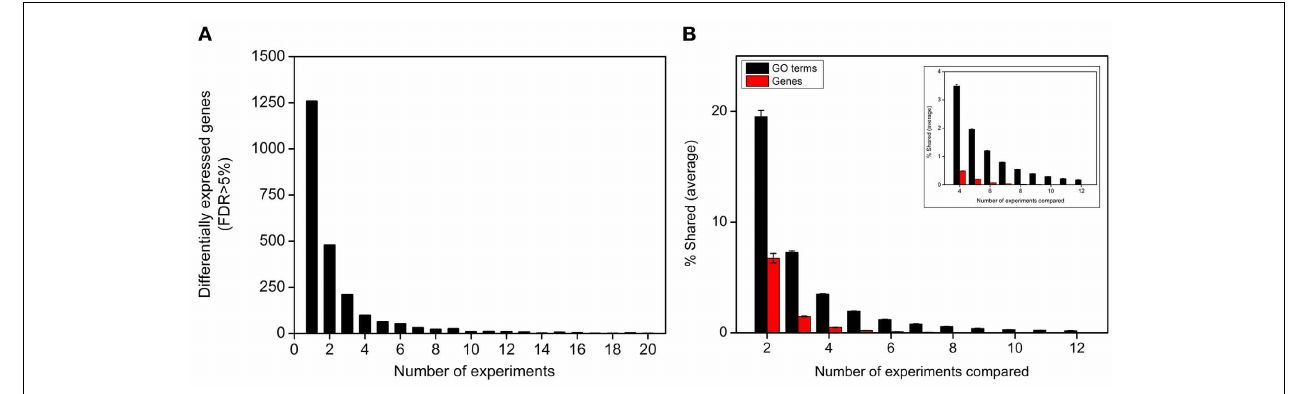
FIGURE 2 | Biological functions are more robust than gene identities in the nitrate response. (A) Histogram of 2286 significantly nitrate responsive genes (rankproduct, FDR < 5%) vs. the number of experiments in which